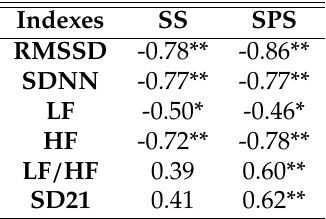
Table 2: Spearman correlation between SS, SPS indexes and time SDNN, RMSSD and frequency